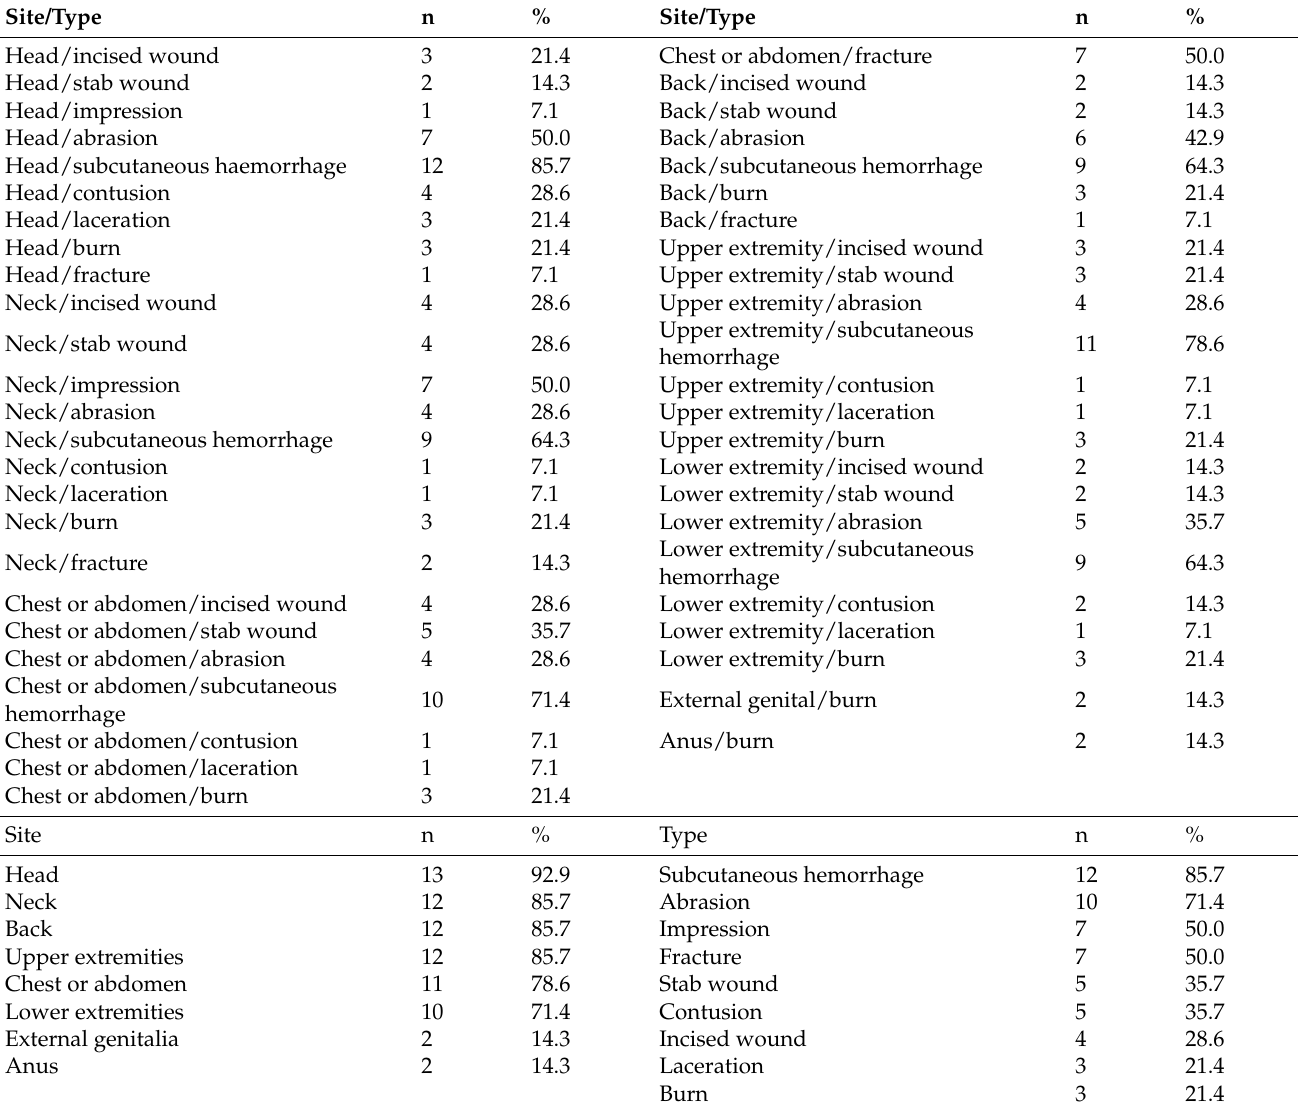
Table 1. Sites and types of injury in cases of elder abuse at forensic medicine